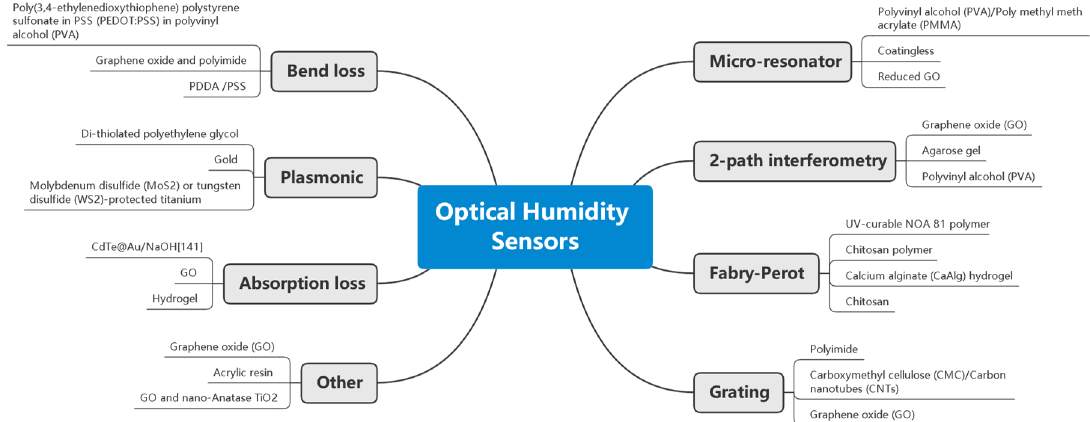
Figure 2. Example functional materials for each type of sensing mechanism.